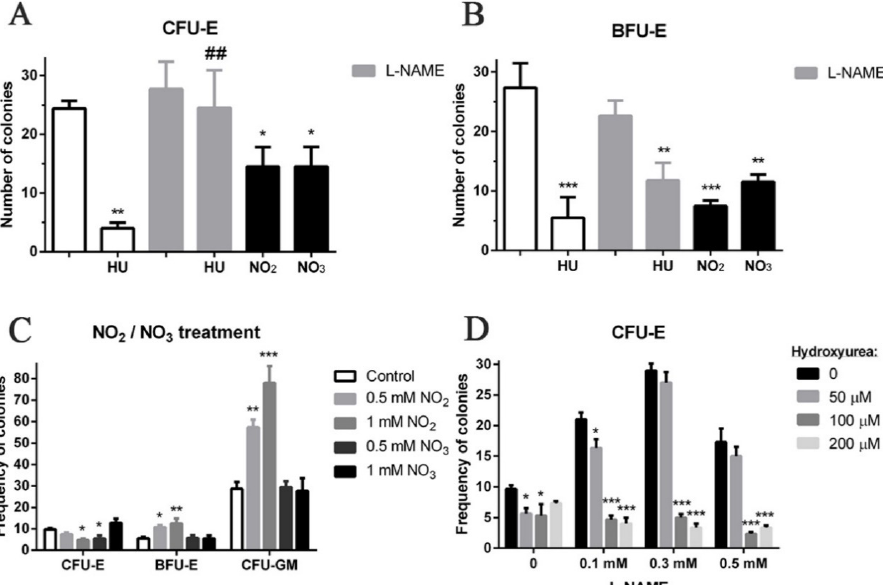
Figure 4. Hydroxyurea and NO derivatives’ induction of erythroid progenitors’ growth of mouse bone marrow origin. Number of ex vivo ( A ) CFU-E and ( B ) BFU-E colonies of mice treated with hydroxyurea (HU, 200 mg/kg), sodium nitrite (NO 2 , 1 mmol/kg), and sodium nitrate (NO 3 , 1 mmol/kg) with or without L-NG-nitroarginine methyl ester (L-NAME, 50 mg/kg) (n = 10); ( C ) NO 2 and NO 3 induction of mouse CFU-E, BFU-E, and CFU-GM in vitro growth; ( D ) Dose dependent